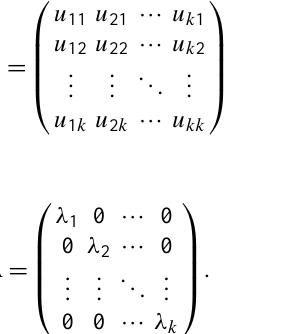
3. Make a covariance matrix S of matrix X ; S = XX T